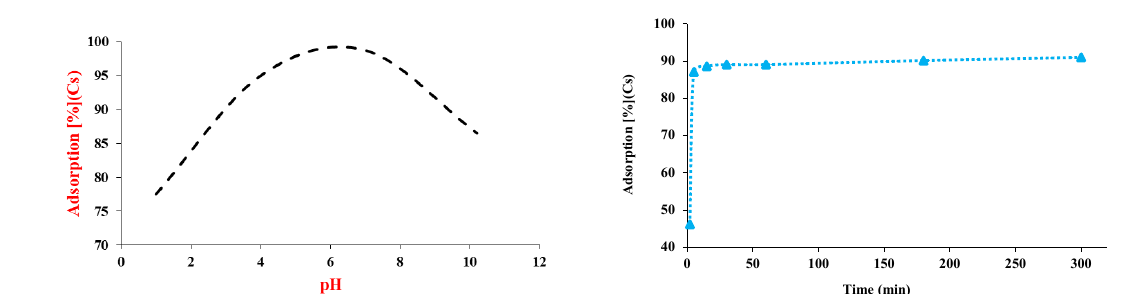
Fig. 5 The effect of pH (1, 4, 7, and 10) on Cs(I) uptake by GO-NiHCF at 20 mgL -1 and 25 °C with continuous shaking at 150 rpm for 5 h.